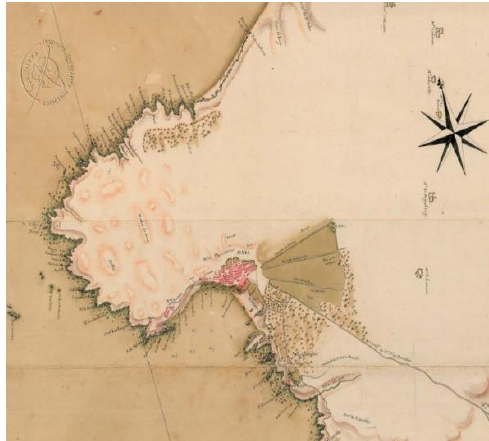
Figure 2. Sines coast map from the ending of the 18th century (extract of the Carta da Costa do Governo de Sines de 1781/1790 ; Chermont and Mota 1790).